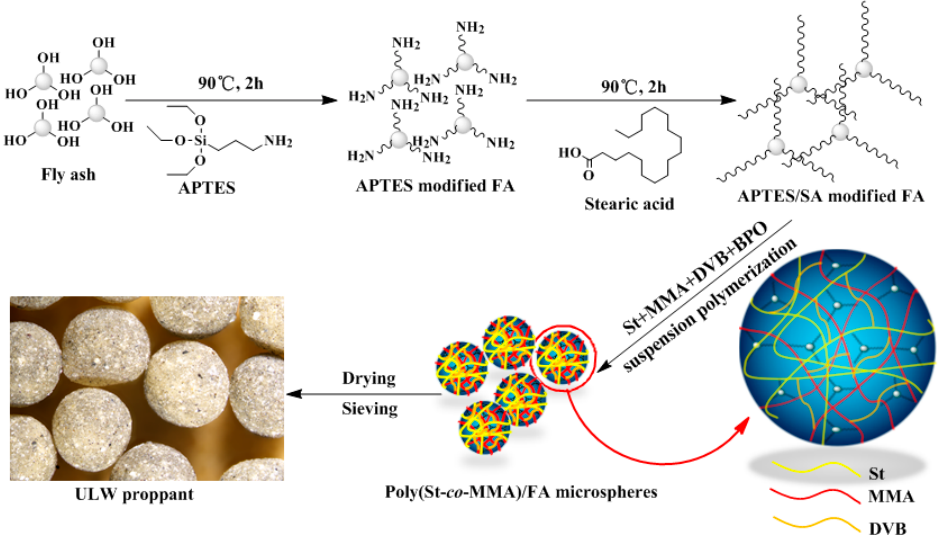
Figure 1. Schemes of the synthetic process of poly(St-co-MMA)/FA composite microspheres.